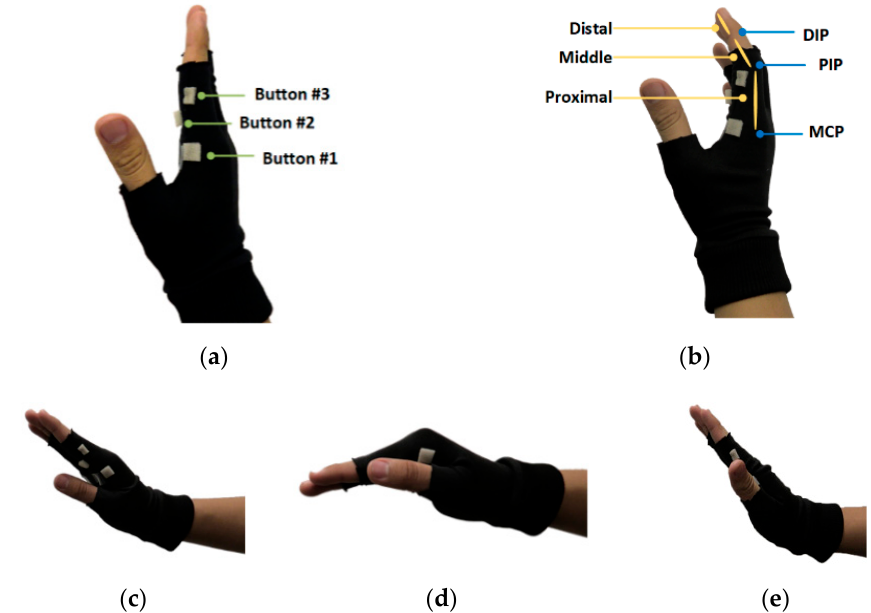
Figure 1. ( a ) Fabric-based prototype used in our study for righthanded participants. Three soft foam buttons (two on the sides of the index finger on proximal and middle phalanges, and one on the palmar side of the index proximal phalange) were glued to a fingerless hand glove design. ( b ) Illustrates the finger joints on the index finger. ( c – e ) Sample gestures supported by in-house developed prototype: ( c ) wrist only; ( d ) touch only; and ( e ) touch and wrist.